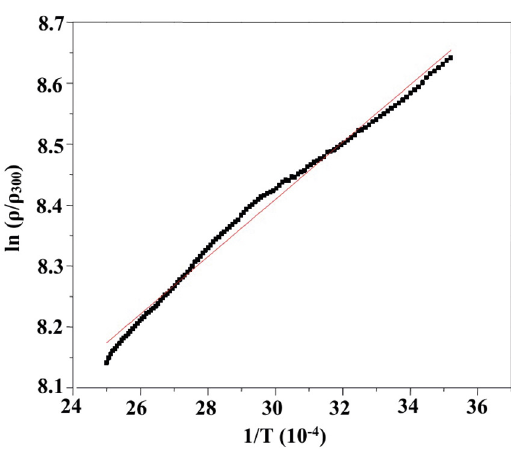
range hopping (VRH) conduction mechanism with ρ α T -1/4 22,23 of ρ for approximately 50-230 K, for all thicknesses t =